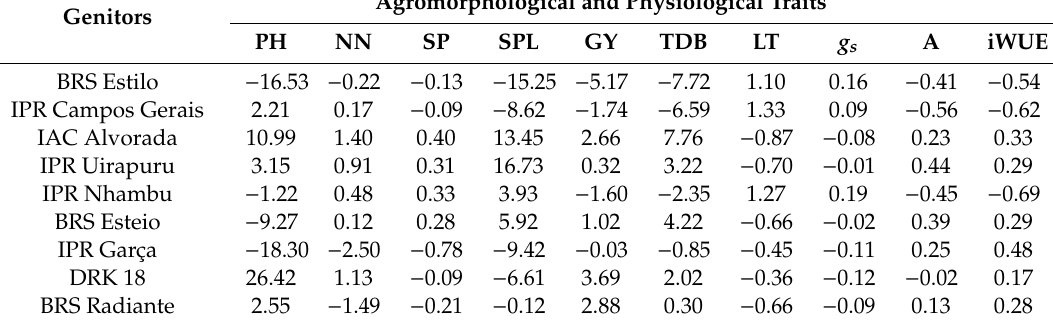
Table 5. Estimates of general combining ability ( ˆ g i ) e ff ects for group II cultivated under the control condition